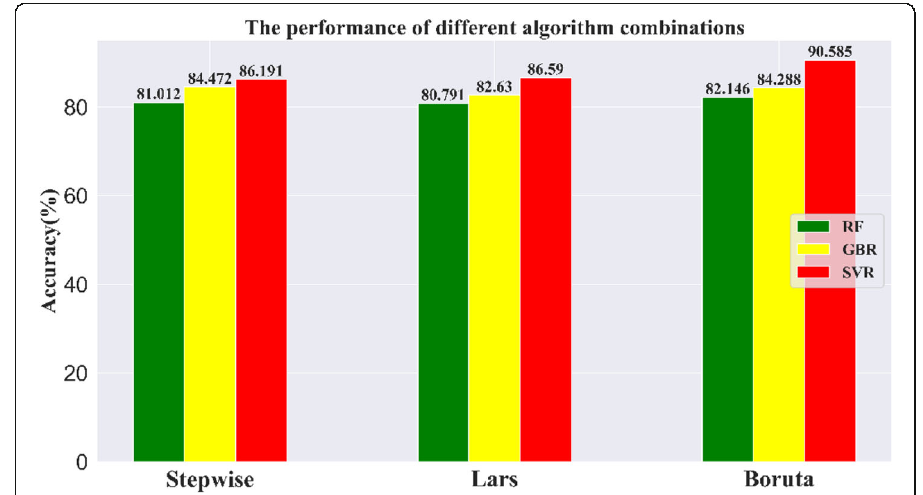
Fig. 8 The performance comparison of nine hybrid models in terms of FS